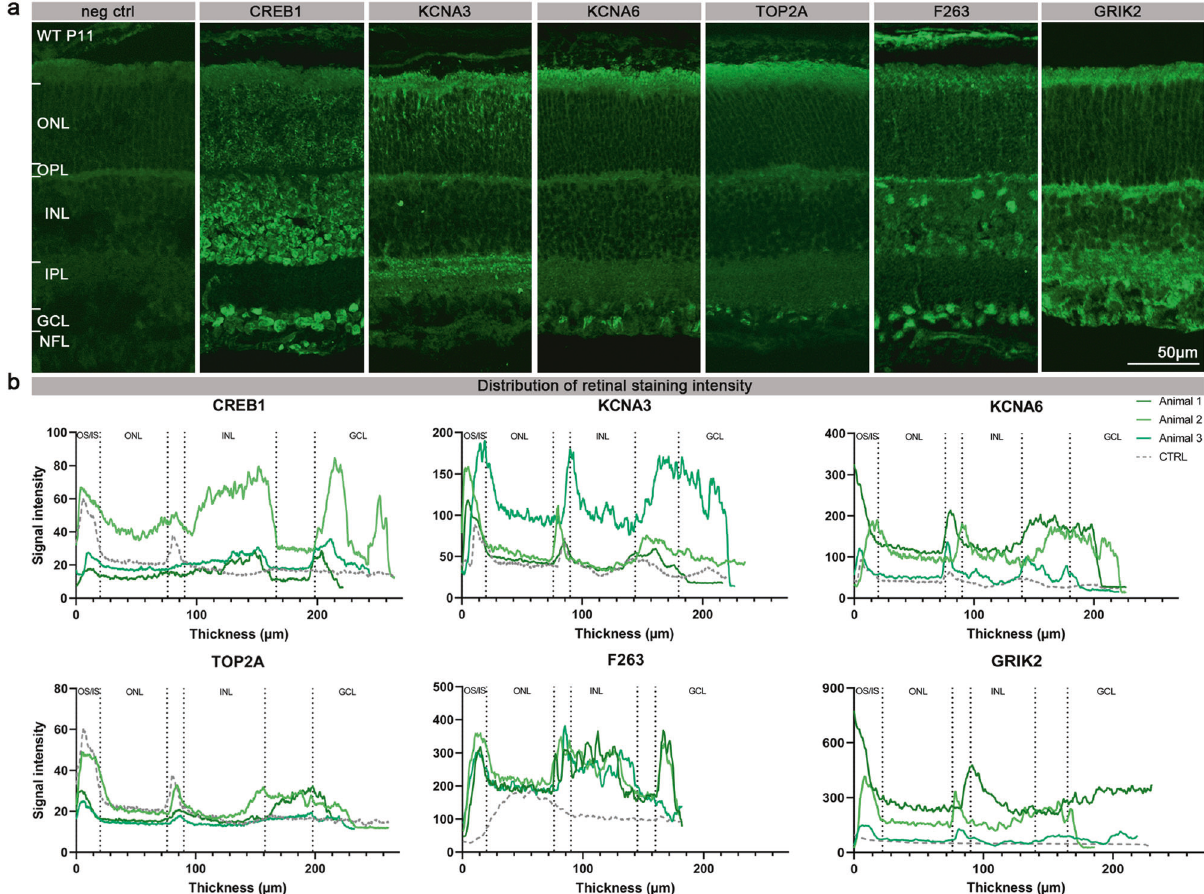
Fig. 5 Presence and localisation of PKG target proteins in the retina. a The panel shows retinal cross-sections derived from P11 WT mice and stained with secondary antibody for negative control (neg. ctrl.), anti-CREB1, anti-KCNA3, anti-KCNA6, anti-TOP2A, anti-F263, or anti- GRIK2. b The localisation of CREB1, KCNA3, KCNA6, TOP2A, F263, and GRIK2 in the retina of WT mice is illustrated by a signal distribution plot along vertical sections across the retina. Antibody labelling obtained on stained retinal tissue sections from three different animals is represented in different shades of green, while the negative control is represented in grey. OS/IS Outer segment/inner segment, ONL Outer nuclear layer, OPL Outer plexiform layer, INL Inner nuclear layer, IPL Inner plexiform layer, GCL Ganglion cell layer, NFL Nerve fi ber layer.